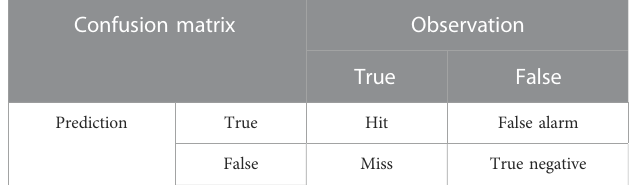
TABLE3Confusion matrixtocalculate metrics.TrueorFalseisdetermined bythe chosen thresholds of 0.1, 2.5, 10, and 20 mm. Confusion matrix